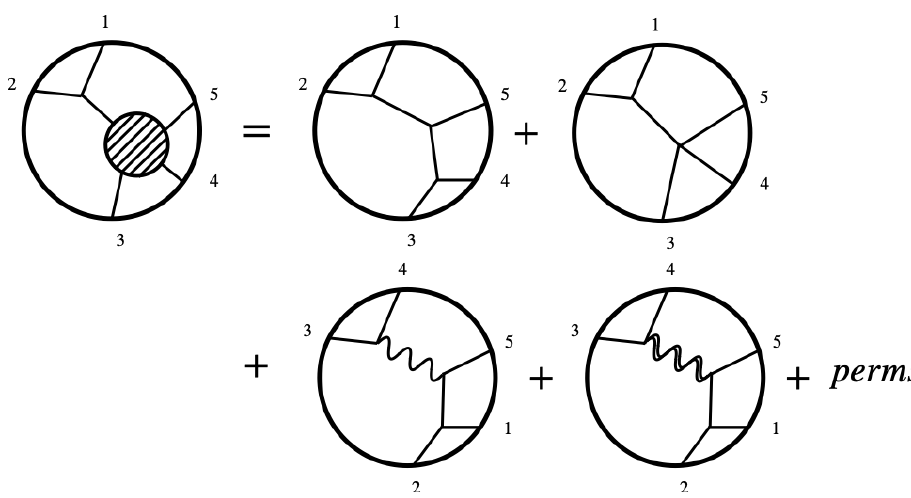
Figure 7. Factorization on an internal scalar line. Here \ perms " denotes the other inequivalent diagrams obtained by permuting the external legs 3, 4 and 5. The scalar single-exchange diagram represents both the zero-derivative diagram and the two-derivative diagram. Upon factorizing the (cid:12)ve-point function on the internal scalar, we obtain a three-point function hO 20 0 O 20 0 O 20 0 i and a four-point function hO 20 0 O 20 0 O 20 0 O 20 0 i